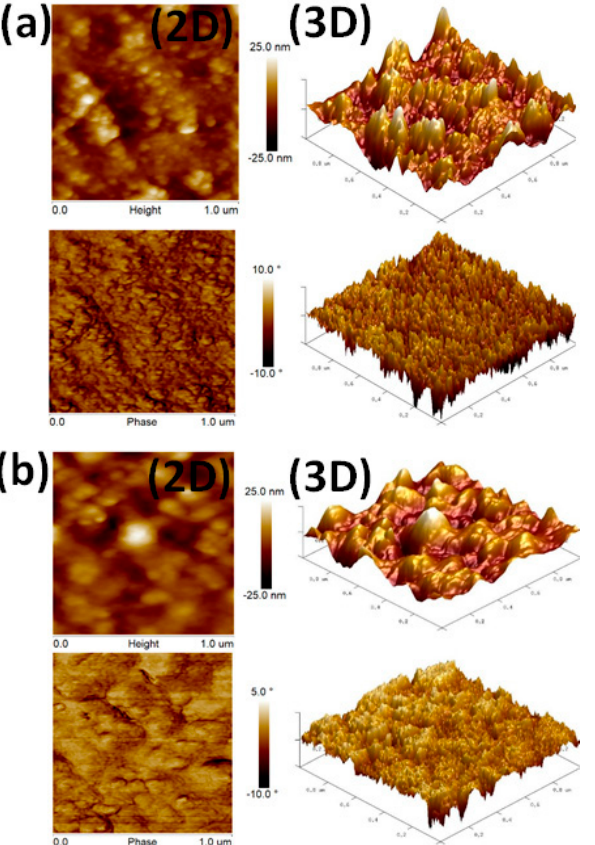
Figure 4. AFM structural analysis of biosynthesized AuNPs ( a ) and AgNPs ( b ) with 2D and 3D images of the height, surface phases, and size of nanoparticles.